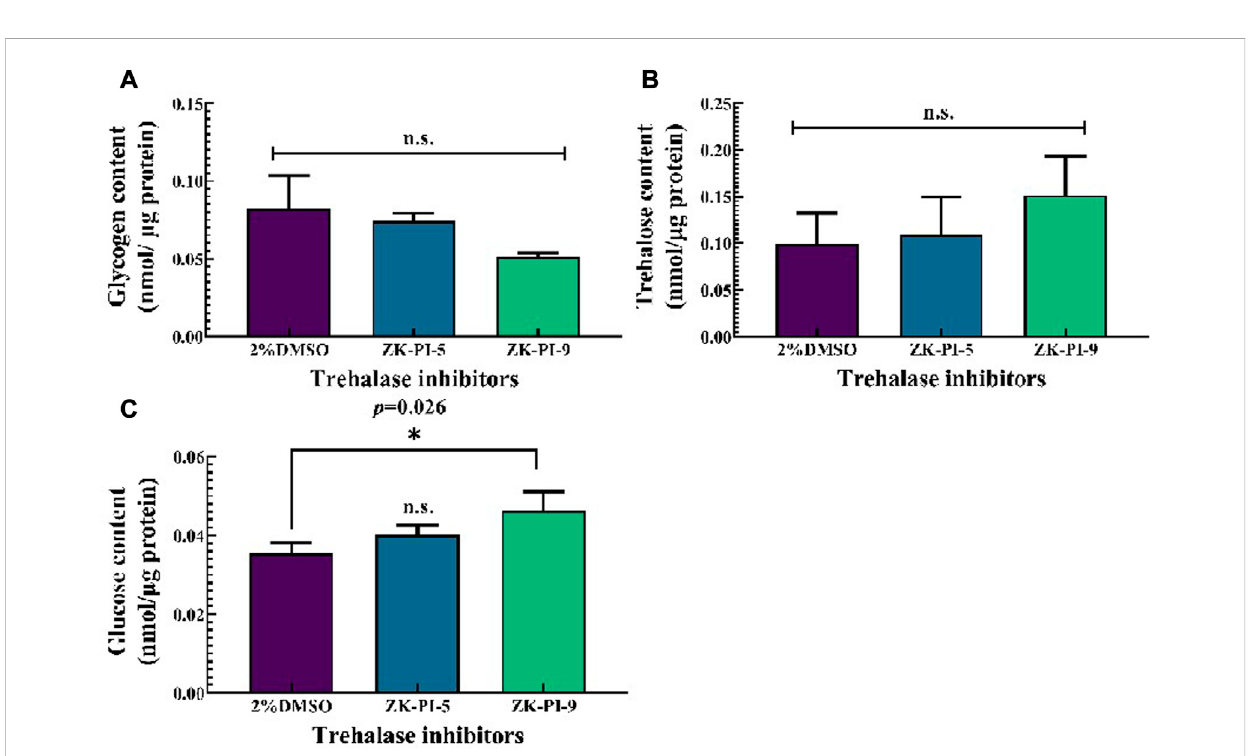
FIGURE 2 Changesintrehalose (A) ,glucose (B) andglycogencontent (C) 48 hafterinjectingtwotrehalaseinhibitors.The S . frugiderda larvaeonthe fi rstdayof the third instar were divided into three parallel groups, injected with two trehalase inhibitors or left untreated, and used to detect the content of the 3 sugars after 48 h. Values are presented as the means ± SE. * p < 0.05 denotes signi fi cant differences. ** p < 0.01 denotes extremely signi fi cant differences, n.s.: not signi fi cant (independent-samples t